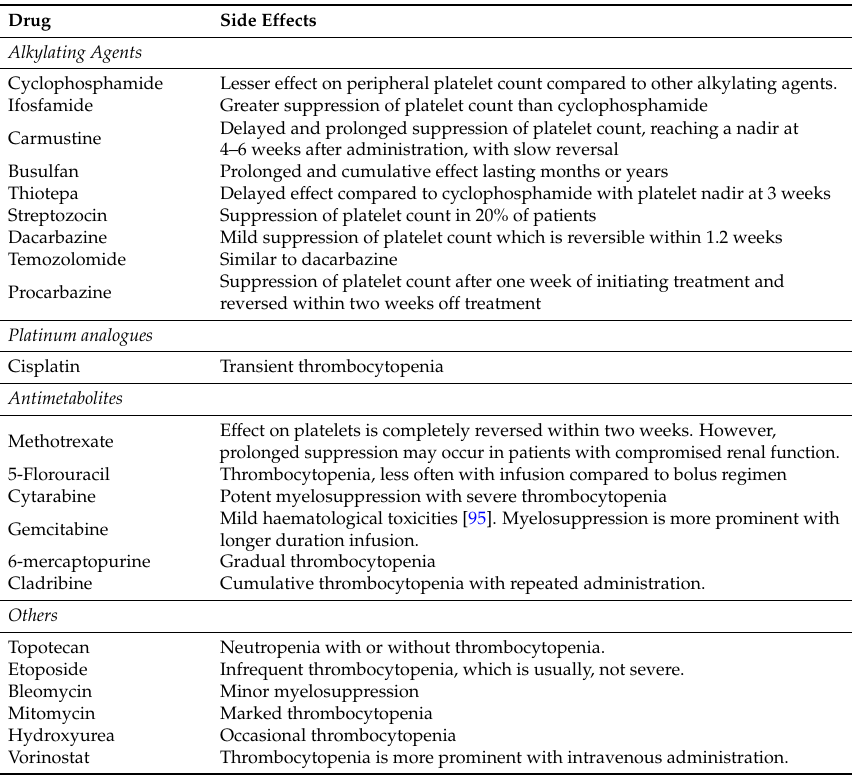
Table 2. Commonly used anticancer drugs and risk of thrombocytopenia